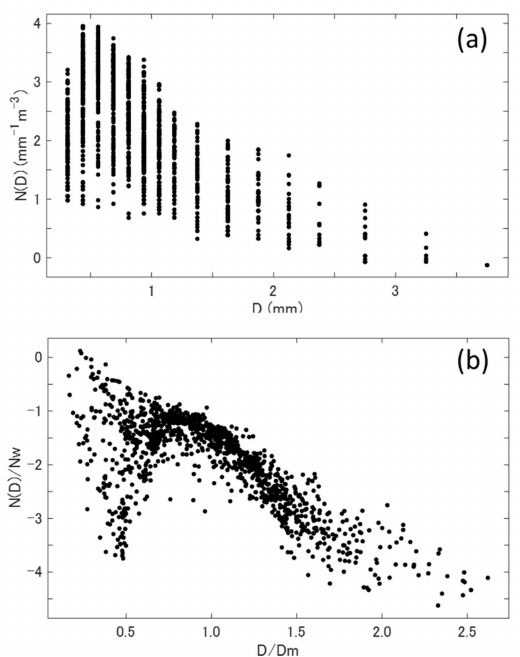
Figure 10. Comparison of PSD before and after normalization: ( a ) N ( D ) vs. D for the six selected volcanic eruptions measured by Parsivel 2 and ( b ) corresponding plot of N ( D )/ N w vs. D / D m